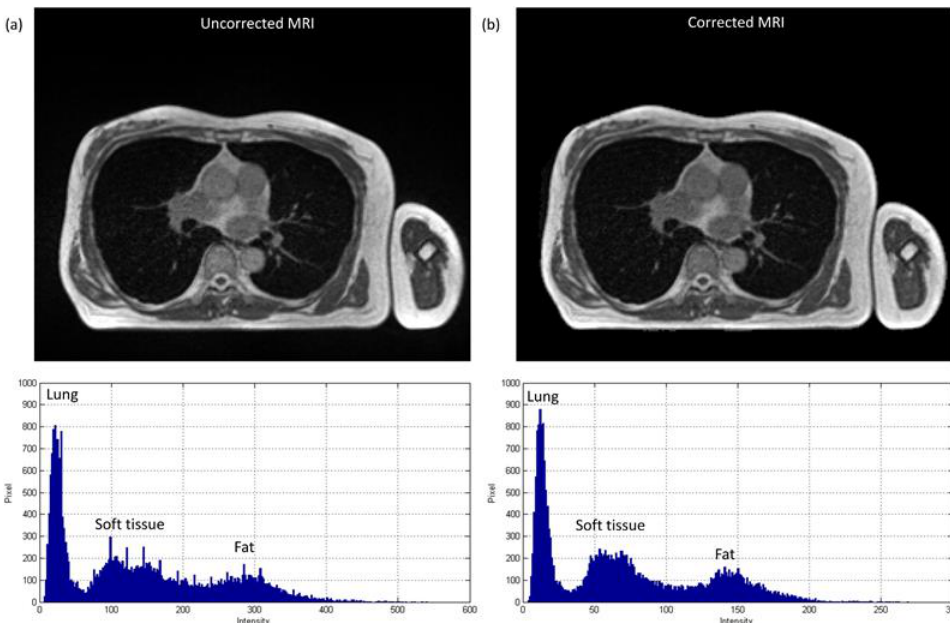
Figure 5. Axial image and histogram of ( a ) uncorrected MRI (WL/WW = 200/400) and ( b ) corrected MRI (WL/WW = 100/200) from 0.35 T scanner for chest imaging used to generate CNN validation dataset ( IMG validationchest ).